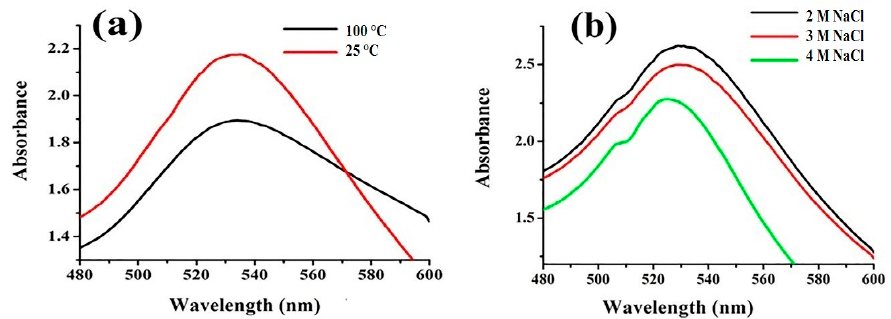
Figure 3. E ff ect of ( a ) temperature and ( b ) salt concentration on the stability of Figure 3. Effect of ( a ) temperature and ( b ) salt concentration on the stability of FAuNPs.